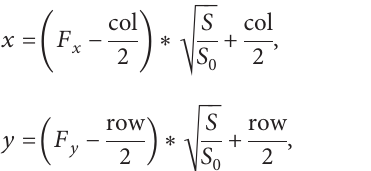
Figure 6: Different facial movement states and FFV differences, where X is F “Normal” stands for normal face posture, and “Right” stands for the right swing of the face.